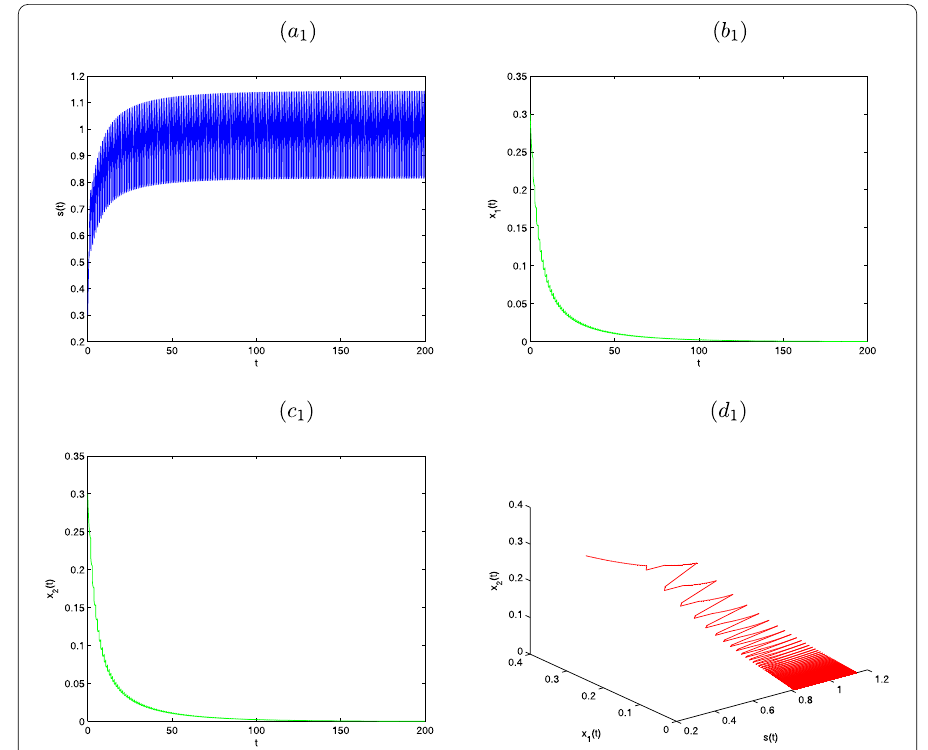
Figure 2 Globally asymptotically stable phytoplankton-extinction periodic solution of system (2.1) with s (0) = 0.3, x 1 (0) = 0.3, x 2 (0) = 0.3, λ 1 = 0.5, d 1 = 0.2, β 11 = 0.5, δ 11 = 1, β 12 = 0.5, δ 12 = 1, d 11 = 0.4, d 12 = 0.4, λ 2 = 0.1, d 2 = 0.2, β 21 = 0.3, δ 21 = 1, β 22 = 0.3, δ 22 = 1, d 21 = 0.3, d 22 = 0.3, E s = 0.3, E 1 = 0.2, E 2 = 0.2, μ s = 0.28,